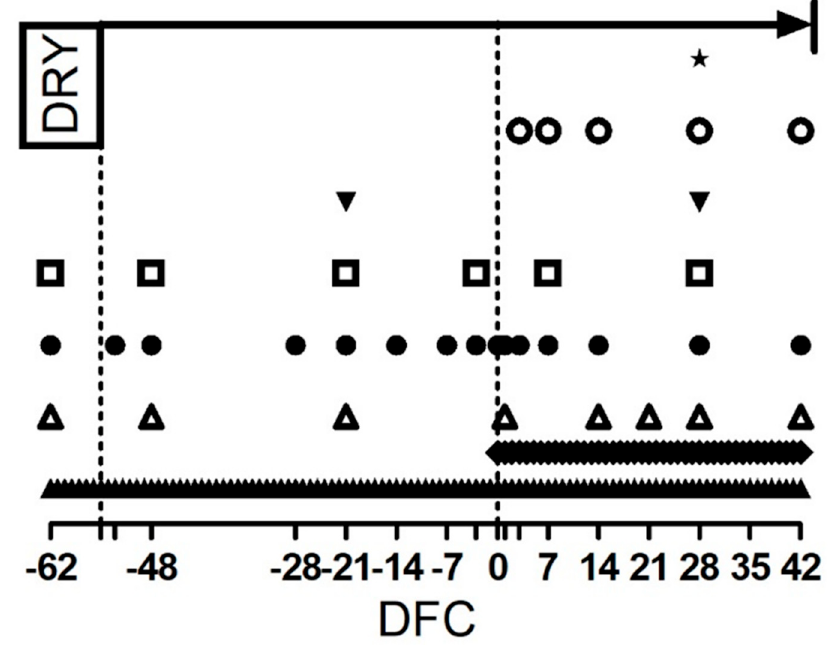
Figure 1. Scheduled time points, expressed as day from calving (DFC), for dry-off (DRY), treatment administration (upper arrow), rumen sample collection ( ), milk sample collection ( ), and blood sample collection for the interferon gamma release assay ( ), carrageenan skin test performance and blood cell profile and whole blood stimulation assay ( ). Blood sample collection for metabolic profile ( ). Milk yield measurement ( ), body weight and body condition score determination ( ), and dry matter intake and rumination time determination ( ). Empty ticks indicate −55, −53, −3, 1 and 3 DFC, respectively.